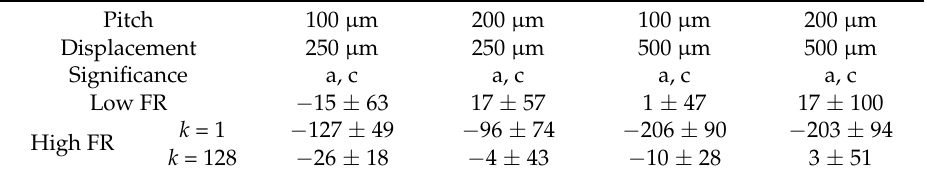
Table 4. Axial estimation errors of the set displacement given as the mean estimation error ± one standard